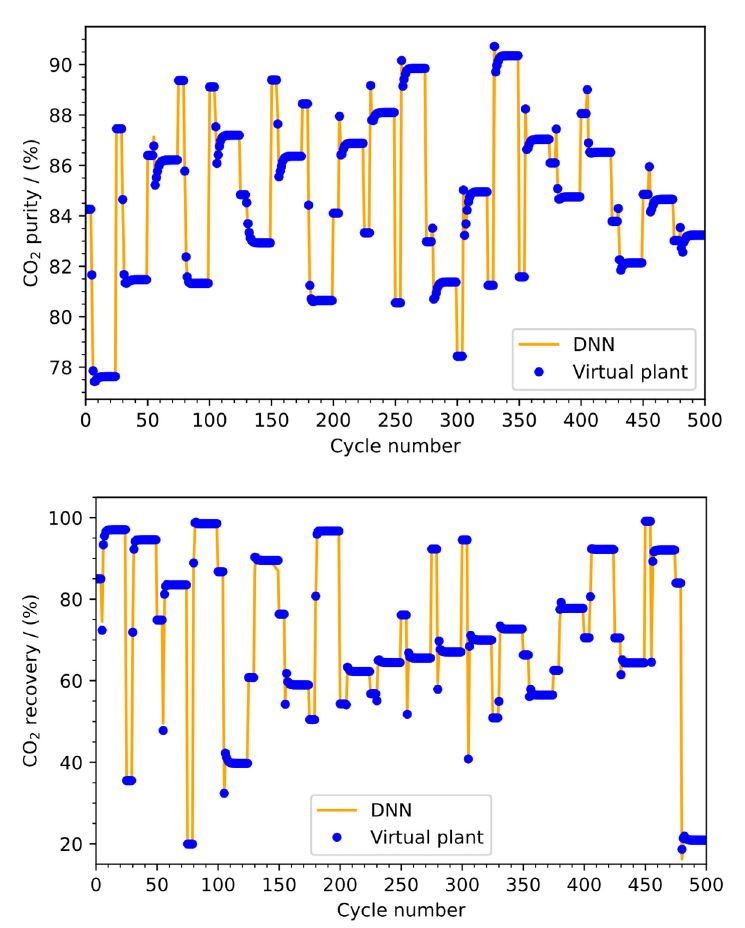
Figure 8. DNN test Figure 8. DNN test performance. Figure 8. DNN test performance.